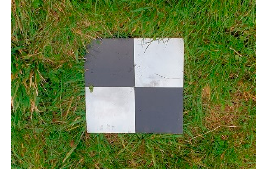
Table 5. Time of flight, number of images, and processing time of each flight. Flight